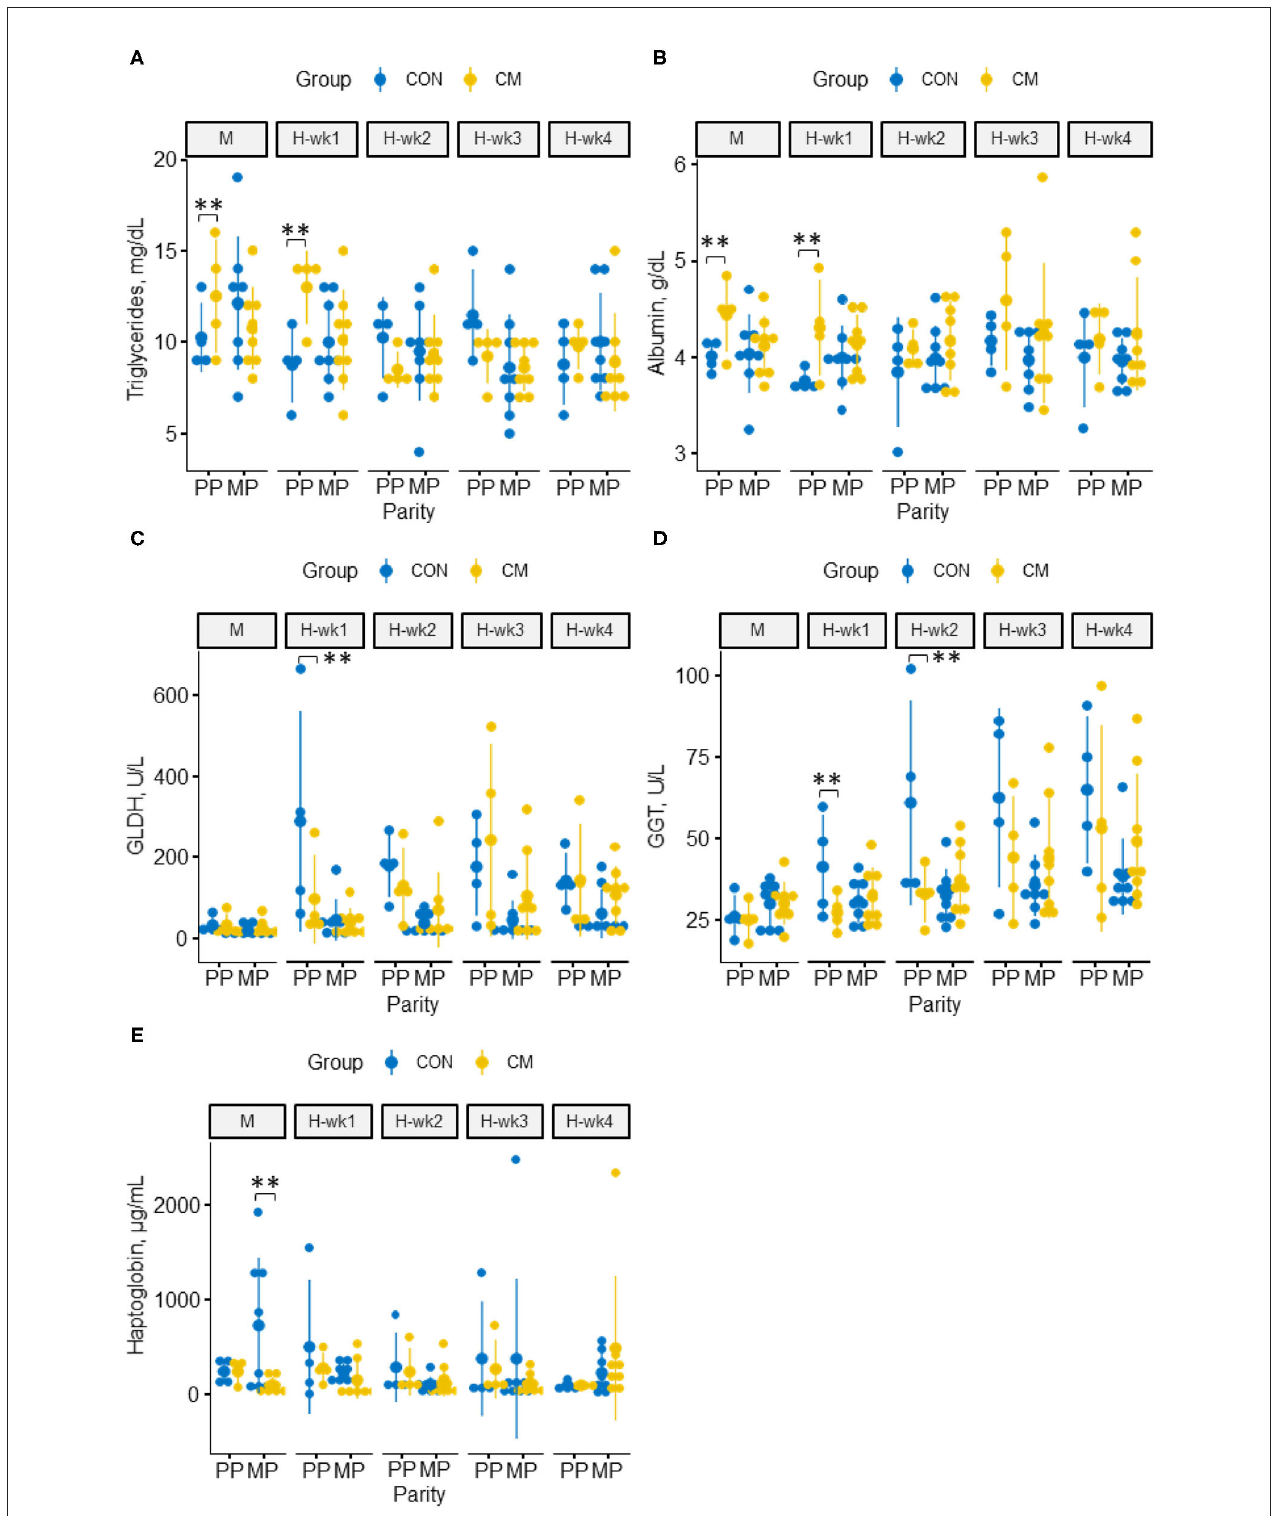
FIGURE 6 | Effect of CM supplementation in primiparous and multiparous cows fed a 40% concentrate diet for 1 week (M) and a 60% concentrate diet for 4 weeks (H-wk1 to H-wk4) on blood metabolites and liver health parameters. (A) triglycerides, (B) albumin, (C) GLDH, (D) GGT, (E) haptoglobin. **indicates significant differences within parities ( p ≤